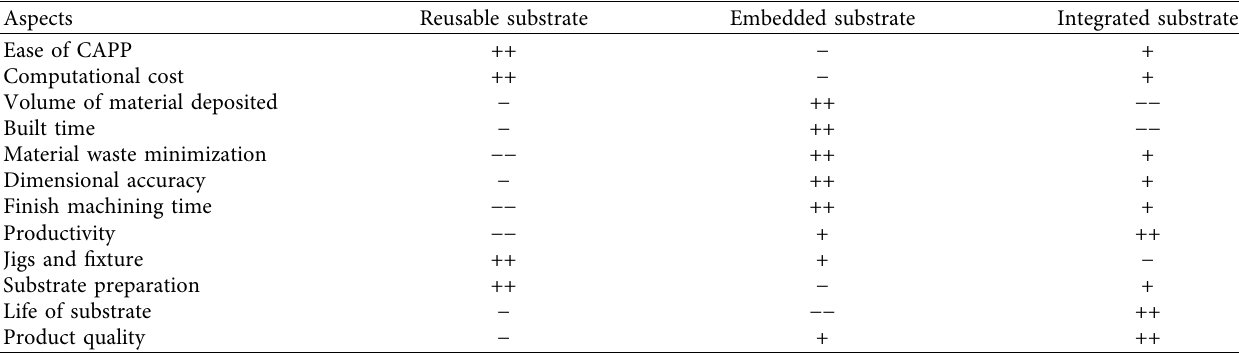
Table 5: Comparison among the proposed build